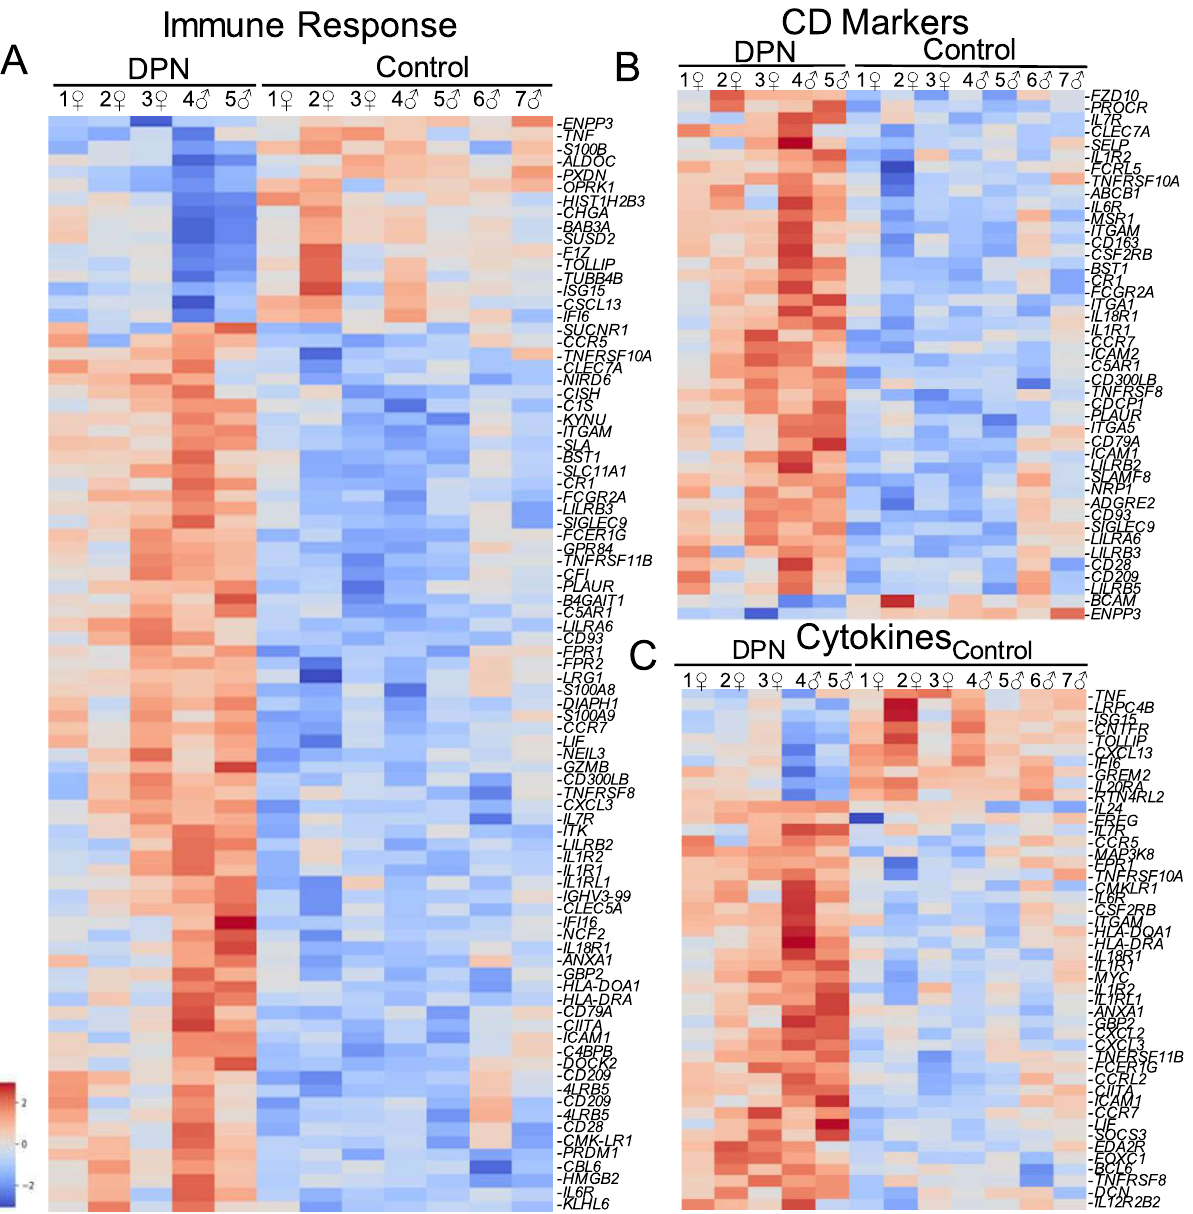
Figure 6. Dysregulated immune response in the DPN individuals: ( A ) Gene enrichment analysis identified 89 genes associated with immune responses in our list 844 DEGs. As shown in the heatmap, most genes were upregulated in the DRG of the DPN subjects while only a few inflammatory genes were downregulated. ( B ) 47 genes were further characterized as involved specifically in cytokine-mediated signaling. ( C ) 44 genes were considered CD markers (HGNC group ID